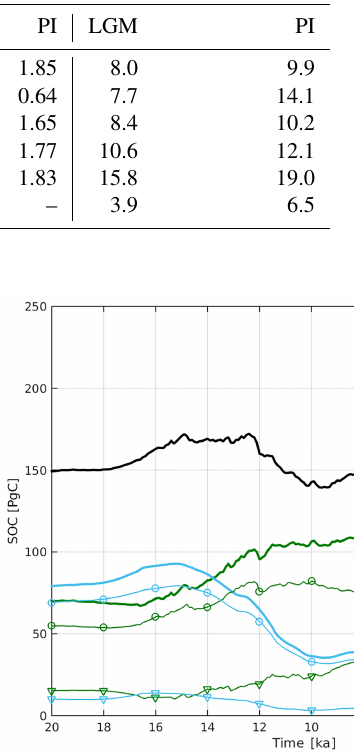
Figure 7. Deglacial evolution of seasonally thawed and perennially frozen SOC in near-surface permafrost from LGM to PI. Total SOC (black line) is composed of seasonally thawed SOC (green lines) and perennially frozen SOC (blue lines). Contributions from North America (lines with triangles) and Eurasia (lines with circles) are shown separately. Data shown represent 100-year time averages and were summed over near-surface permafrost grid cells (accounting for temporally evolving permafrost